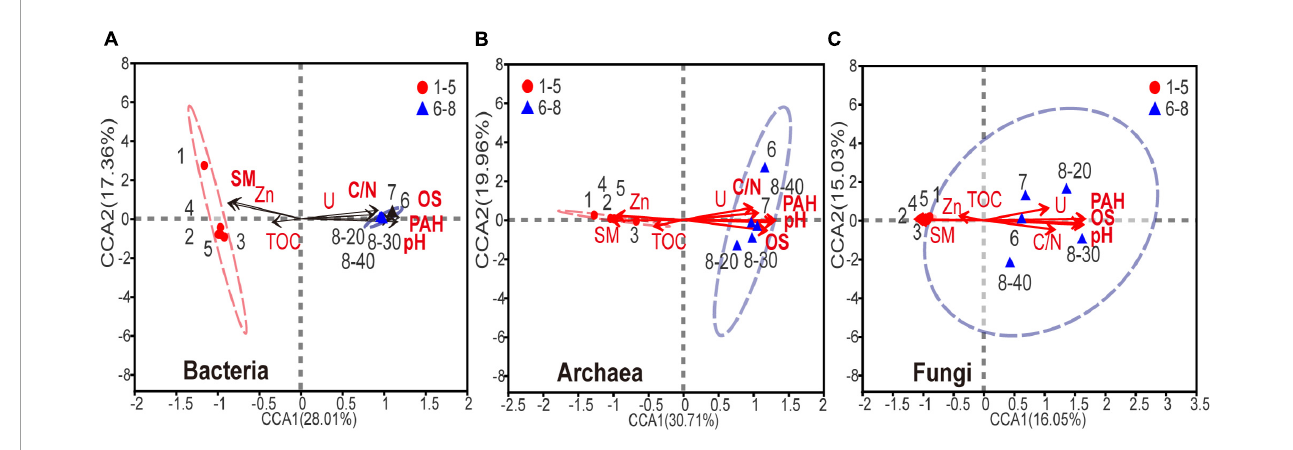
FIGURE5 Canonical correspondence analysis of (A) bacterial, (B) archaeal, (C) fungal community composition and the subset of seven environmental variables (including SM, PAHs, DBT, OS, TS, Se, V, C/N and pH). The environmental variable in bold font represents P < 0.05.